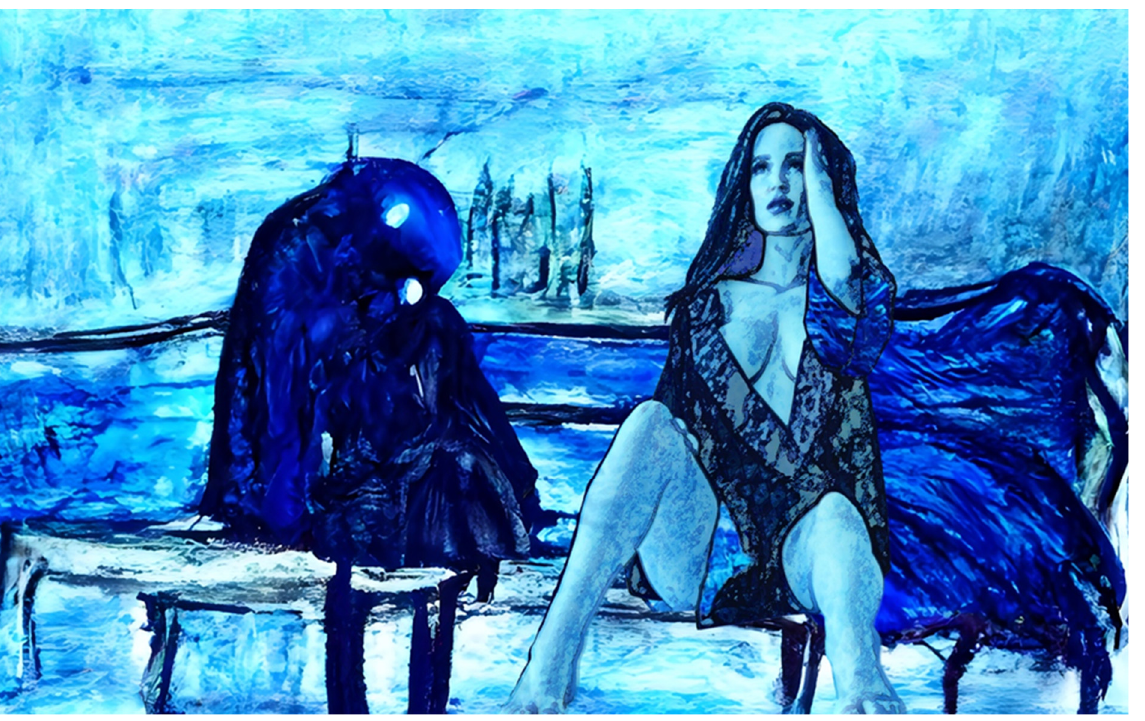
Figure 3. Madeleine + Do you feel loneliness? By Graeme Revell, 2022. Photograph, GPT-2/DALL-E2 image and text.